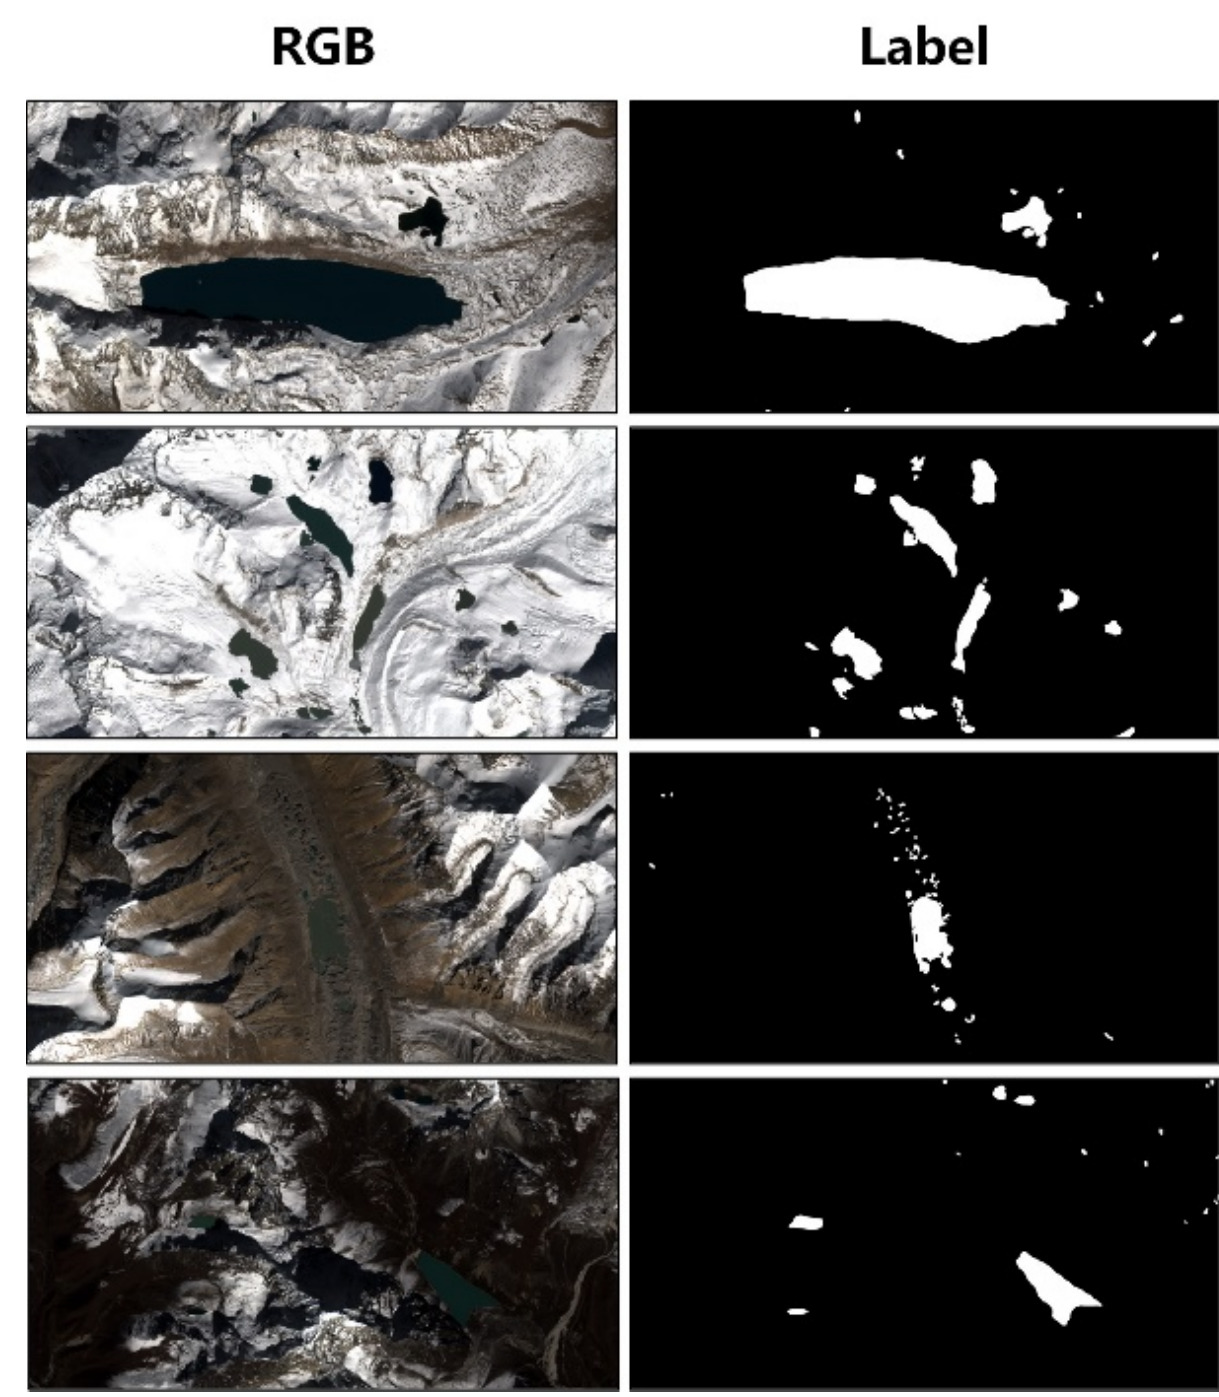
Figure 2. Examples of Sentinel-2 RGB composites of alpine lakes and corresponding labels used for segmentation.